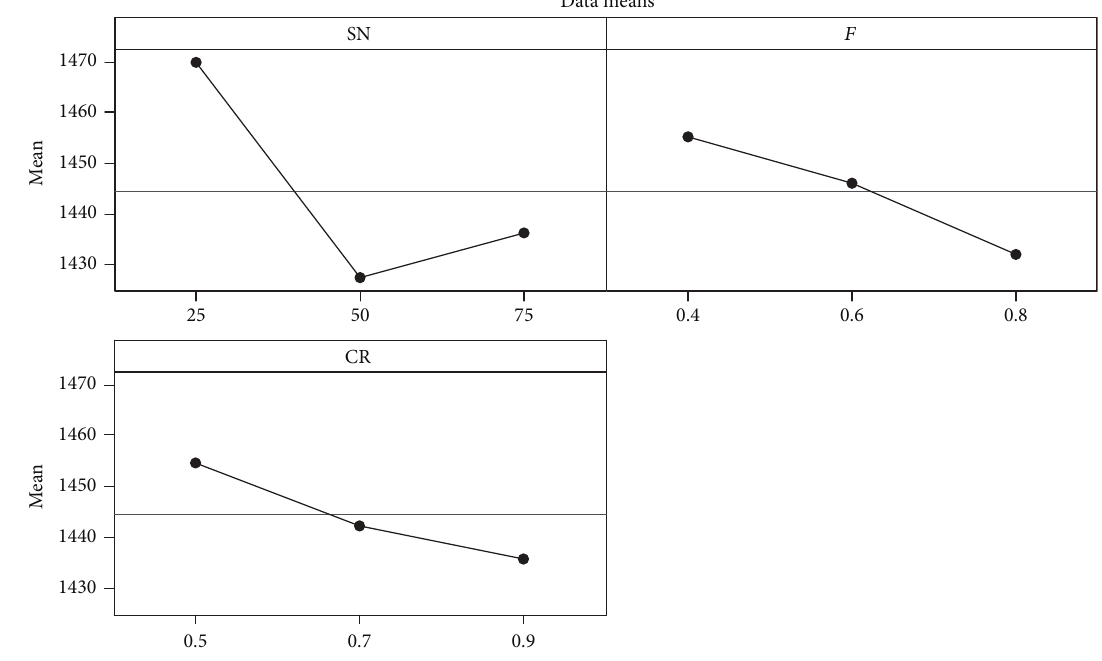
Figure 2: The impact of Stage 2